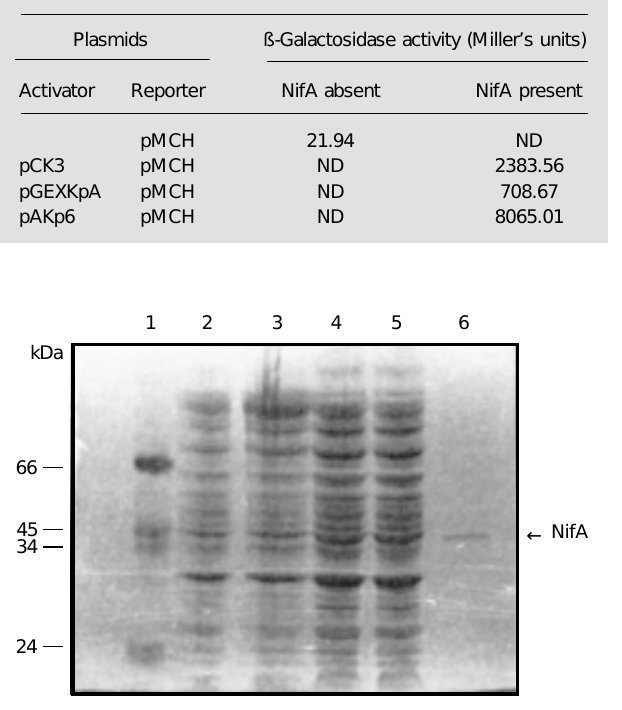
Figure 4 - Purification of NifA from E. coli BL21 (pGEXAbA). SDS-PAGE of denatured samples. Total E. coli extracts containing the GST-NifA fusion protein present in the supernatant (lane 2) and pellet (lane 3). Total E. coli extracts containing the A. brasilense NifA protein, after cleavage with thrombin, present in the supernatant (lane 4) and pellet (lane 5). Lane 6, 1 µg of purified NifA preparation and lane 1, molecular mass standards (Pharmacia). The position of NifA is indicated by the